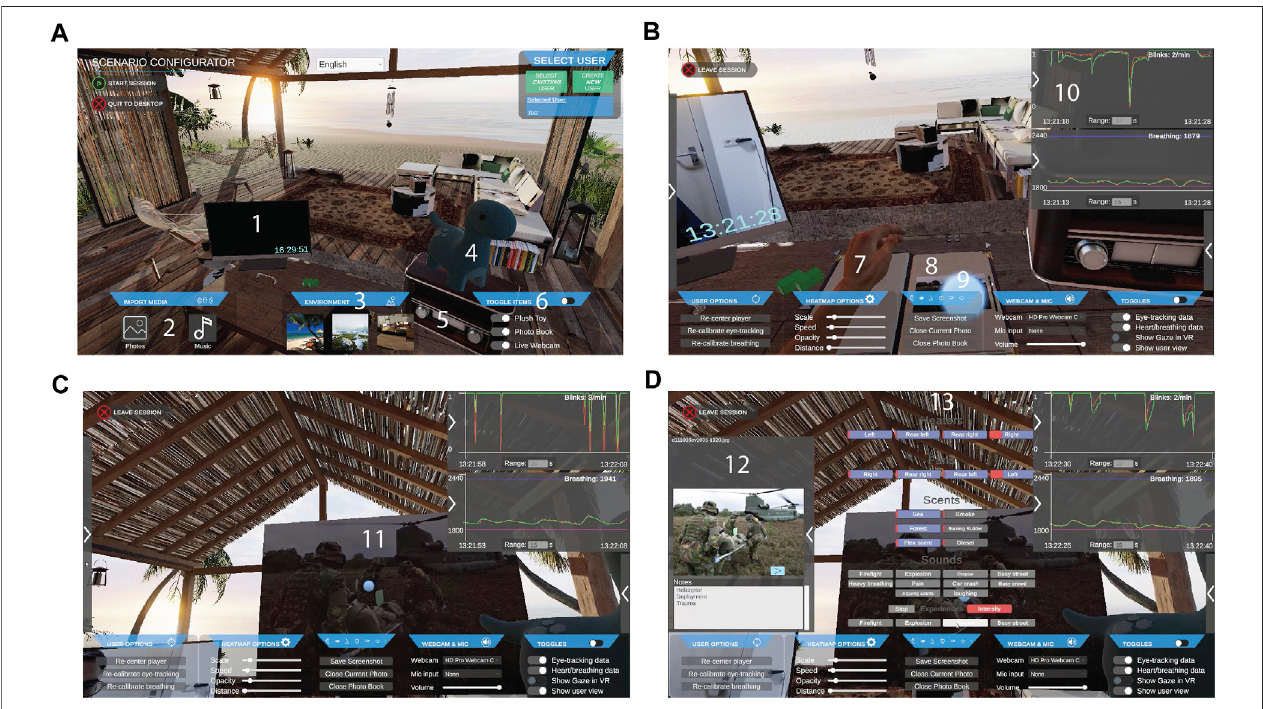
FIGURE 2 | VR exposure application (A) Scenario con fi gurator screen with view of the selected virtual environment for the session, in this case a beach cabin (B) Therapist view during a session. Participant can browse through virtual photo album with self-provided photographs (C) The selected photo can be enlarged by the participant for in-depth discussion. The Therapist can follow the participants ’ gaze via eye-tracking measurements (D) The Therapist can add notes to the photo, that appear in the virtual photo book and immersive elements to the experience (heat, wind, scents and sounds) via a pop-up menu. 1: Interaction with the therapist in sessionoccurs via awebcam,thetherapistisdisplayedonthisscreeninthevirtualenvironment.2:Inthescenariocon fi gurator,mediasuchasphotosandmusiccanbe selected. 3: One of three virtual environment can be selected for the session: a beach cabin (shown here), a cabin in the woods and a living room. 4: A plush toy with whichtheparticipantcanvirtuallyinteract.5:Self-providedmusiccanbeswitchedon,paused,andfast-forwarded via thisvirtualradioset.6:Severalvirtualitemscanbe added. 7: Participants interact with the virtual world through hand tracking. 8: The participant can browse through the self-provided photos in the virtual photo book. 9: The gaze of the participant as measured with eye-tracking. 10: Respiratory and eye-lid measurements are visible for the therapist. 11: Enlarged photo from the virtual photo book. 12: Therapist view of the photo book, the therapist can add notes. 13: Pop-up menu for adding immersive elements to the virtual experience.